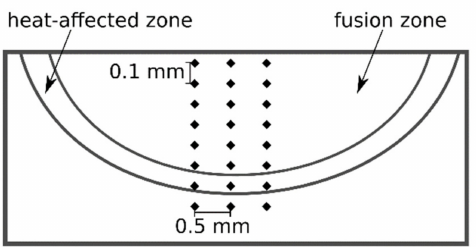
Figure 2. The Vickers hardness measurement point distribution on the cross-sections of laser- alloyed